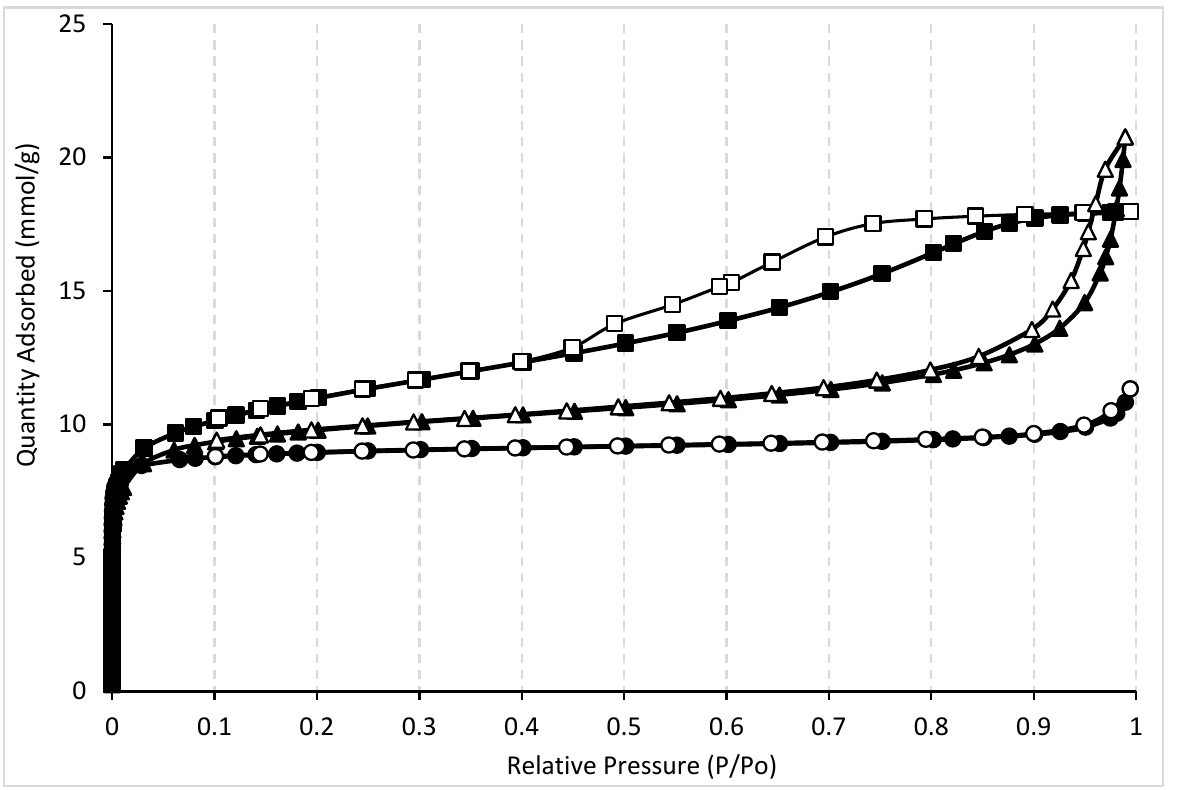
Figure 1. N 2 -adsorption–desorption isotherms measured at 77 K. for the micro-UiO-66 ( ● ), meso-UiO-66 ( ■ ) and meso-NH 2 -UiO-66( ▲ ) materials (solid symbols—adsorption, open symbols—desorption) and Au@meso-NH 2 -UiO-66 - before- and -after-catalysis nanohybrids.